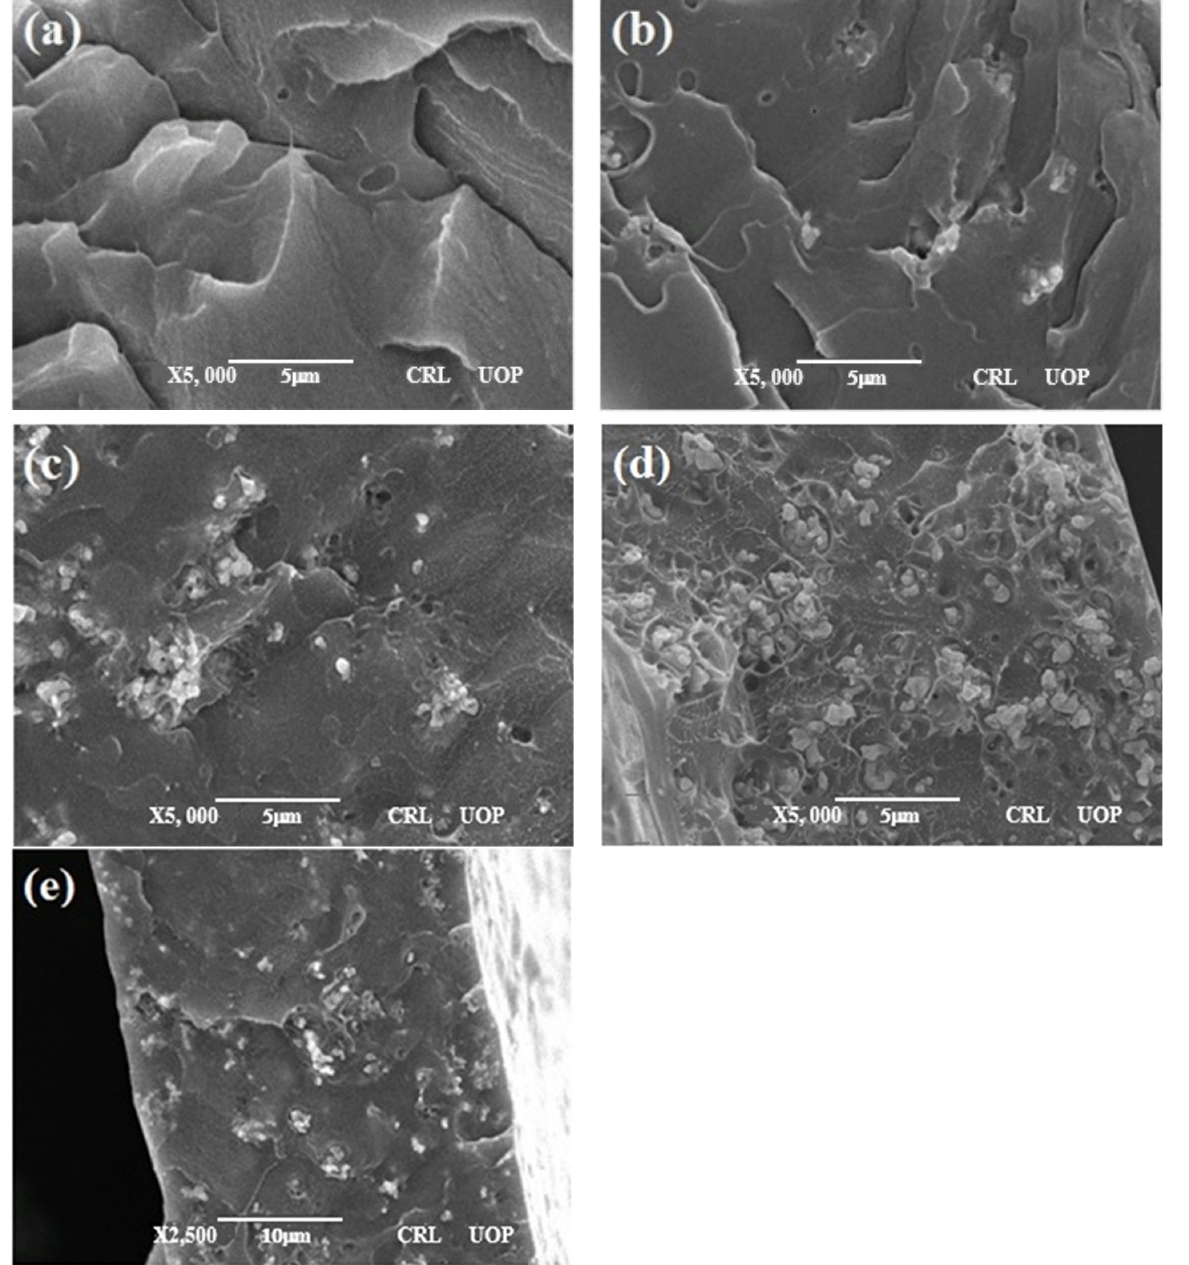
Figure 3. SEM images of PVC/BT composite thick films. ( a ) 0%, ( b ) 10%, ( c ) 20%, ( d ) 30%, ( e ) cross sectional view showing the thickness of films.